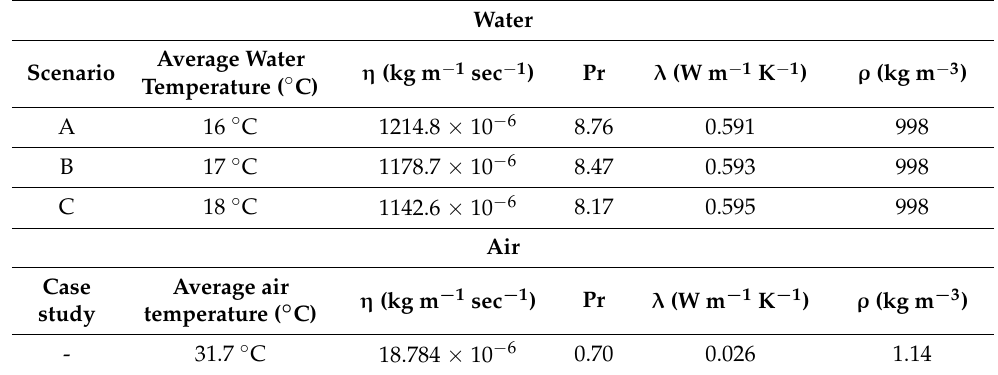
Table 4. Physical properties of working fluids for each scenario.